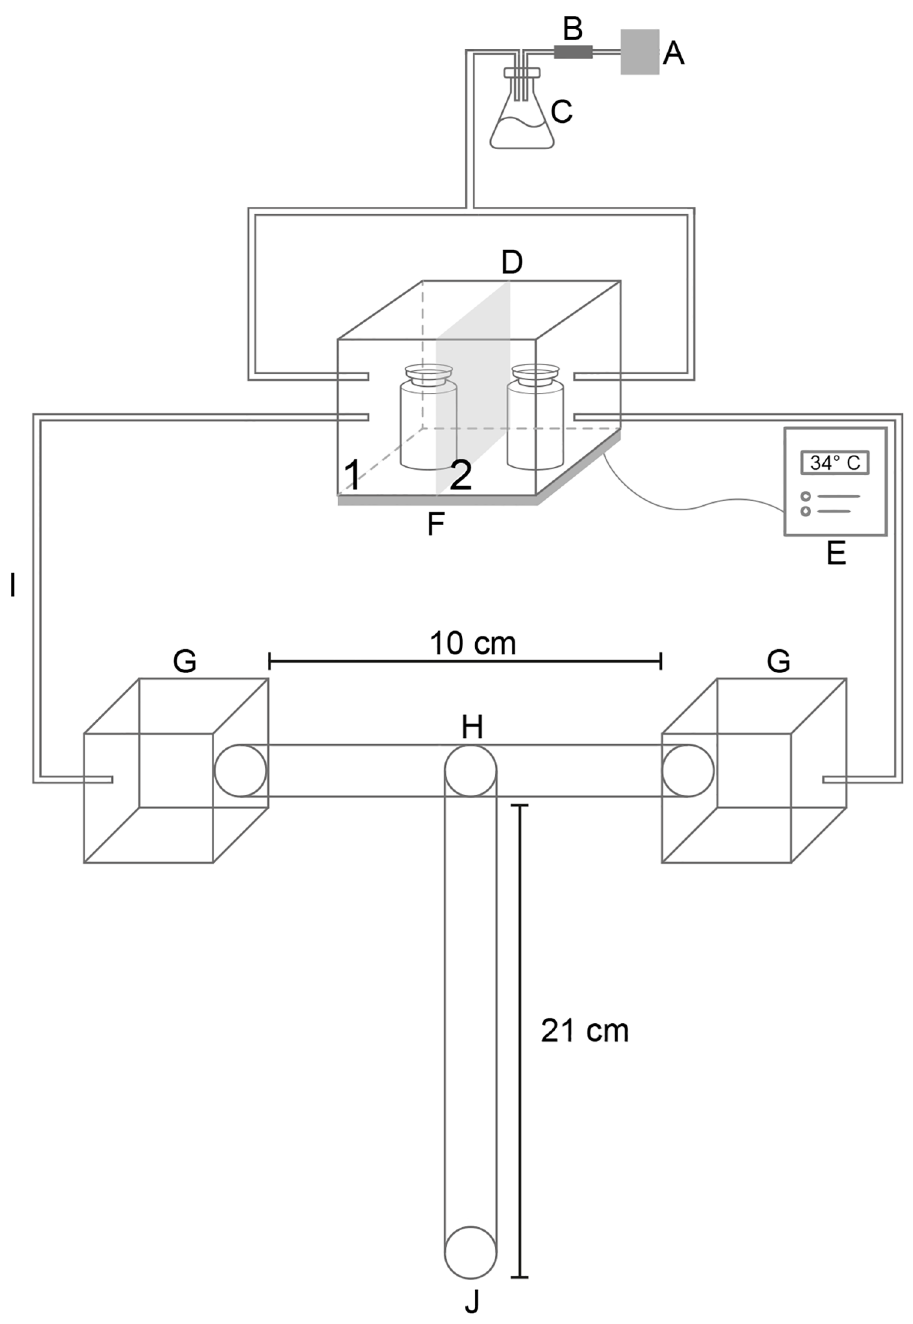
Fig 1. “T”-shaped olfactometer used to evaluate behavioral responses in Rhodniusprolixus to VOCs released in vitro by bacteria. A. Air pump. B. Charcoal filter. C. Erlenmeyer flask to humidify the air flow. D. Hermetic box with two sides (1: vial with standard liquid medium containing bacteria in exponential/stationary phase, 2: vial with standard liquid medium without bacteria). E. Thermostat. F. Hot plate. G. Hermetically sealed transparent packages. H. Insect decision point. I. Transparent hoses (airflow connected with the olfactometer). J. Insect starting point.